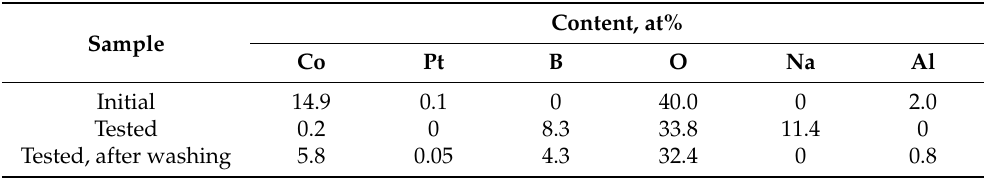
Table 2. XPS data of surface composition of the Pt 0.2 Co 99.8 sample: initial and after testing in 10 cycles of the NaBH 4 hydrolysis without and with water washing.